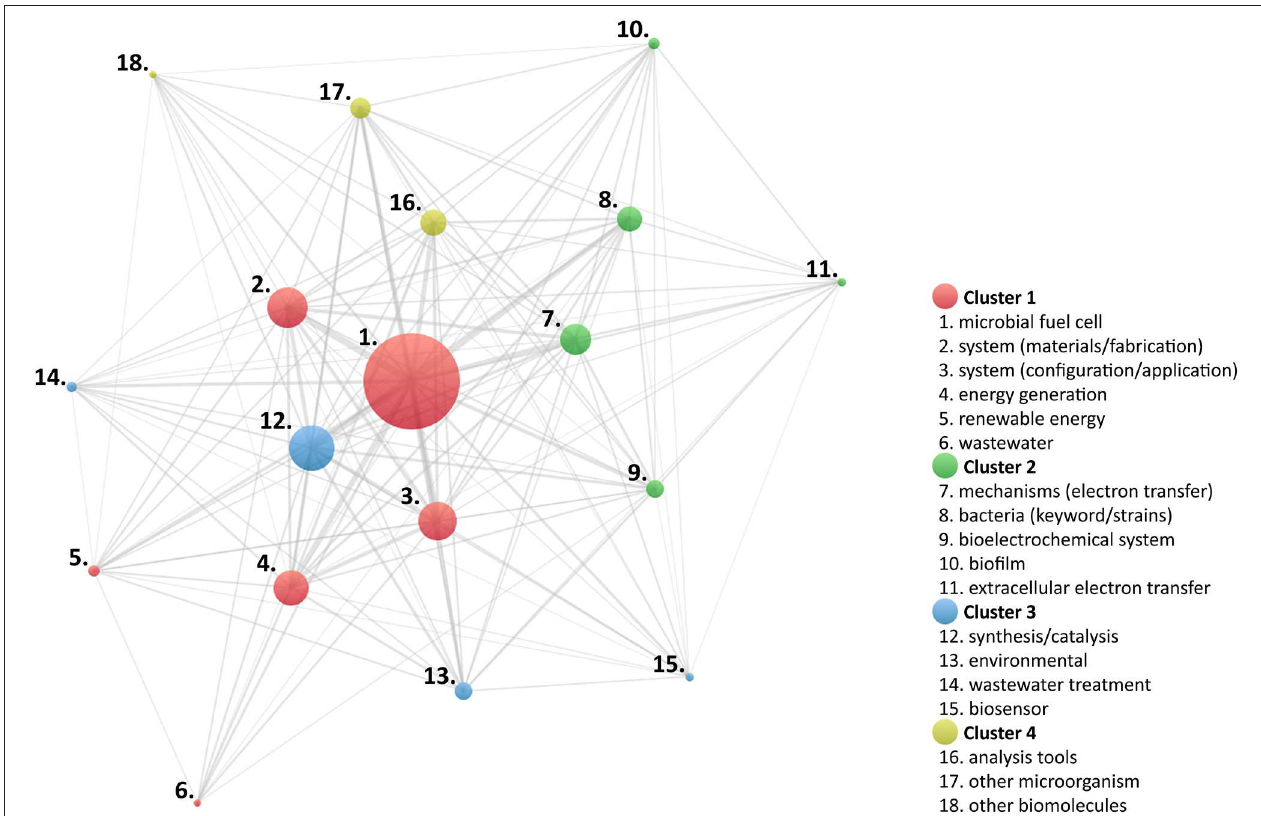
FIGURE 7 | Concept map of the cluster analysis of main and category